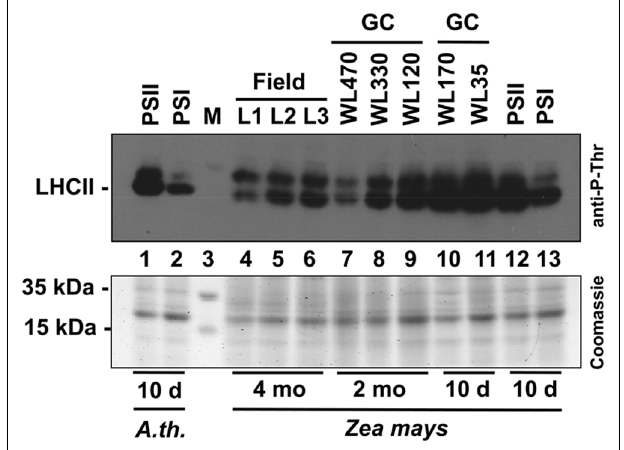
FIGURE 7 | Redox-dependent phosphorylation of LHCII in maize grown under field conditions or various laboratory conditions. Protein extracts of differentially grown plants were separated on a denaturing 10% SDS-PAGE, blotted to a PVDF membrane and subjected to an immunoblot analysis using an anti-phosphothreonine antibody (top panel). Signals were visualized by enhanced chemiluminescence. 20 μ g total protein were loaded per lane. A parallel control gel was loaded with the same protein amounts from the same samples and subjected to Coomassie staining as loading control (bottom panel). Lanes 1 and 2: extracts of 10-day-old Arabidopsis seedlings grown under artificial PSII- and PSI-light serving